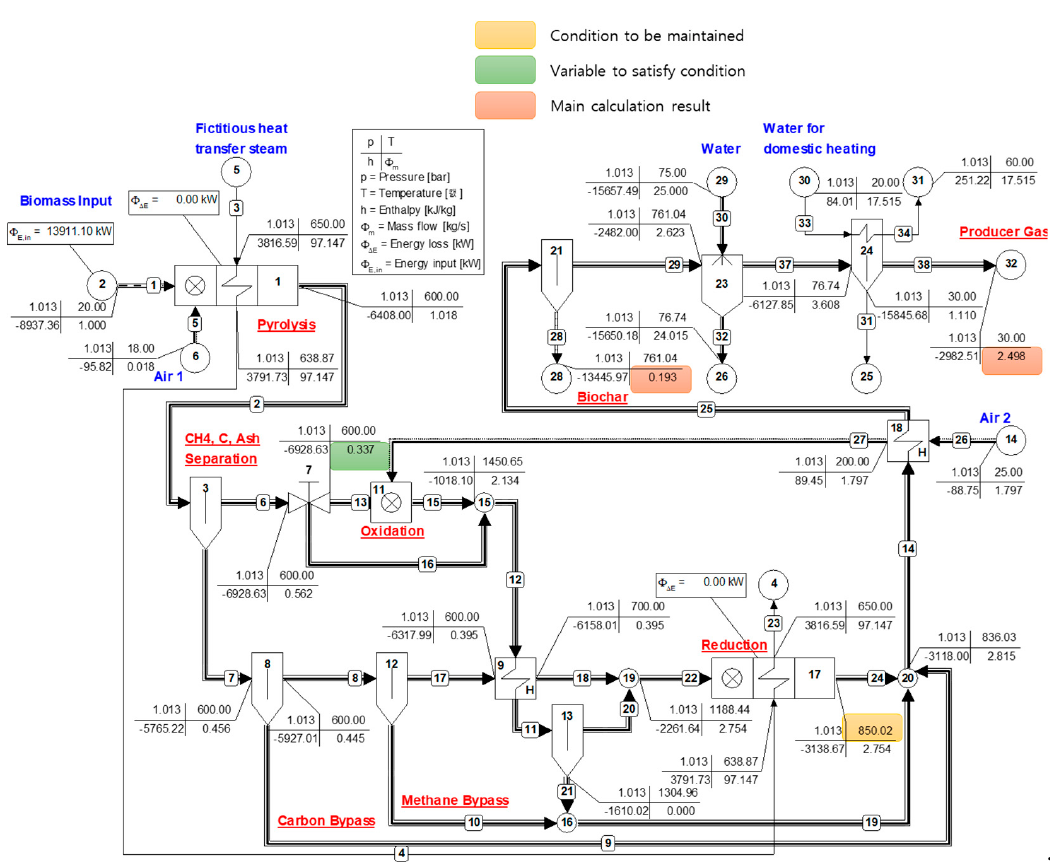
Figure 5. A sample of parametric study of increasing CDR at three ‐ reactor models using rice husk as fuel and CDR 5%. Table 4. Parametric study result for three ‐ reactor models.